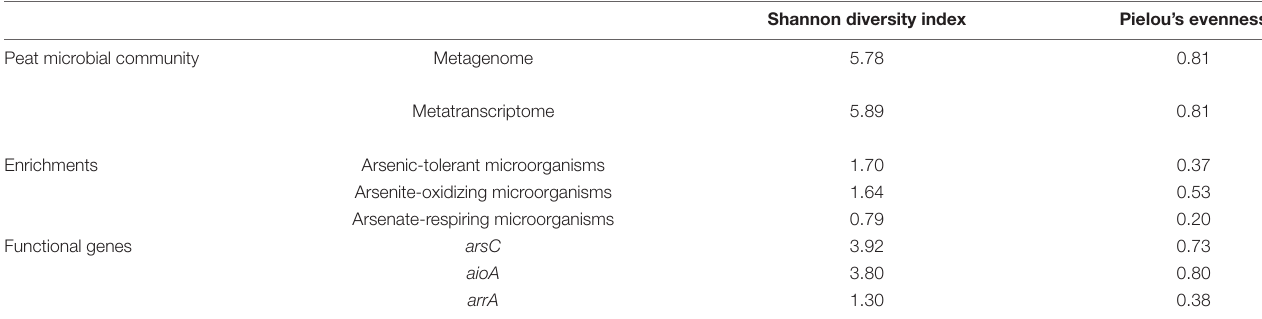
TABLE 2 | Genus-level diversity of metagenomic and metatranscriptomic peat microbial communities, enrichments, and functional genes involved in arsenic metabolism expressed as Shannon diversity and Pielou’s evenness.